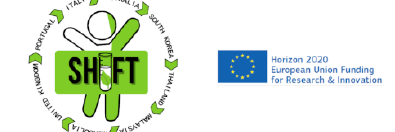
Table 2. Transglutaminase row, second column. “Catalyse” should be “catalysed”. 23. Section 5.4.2. The first paragraph, the Celsius degree symbol for diamondback squid is the wrong